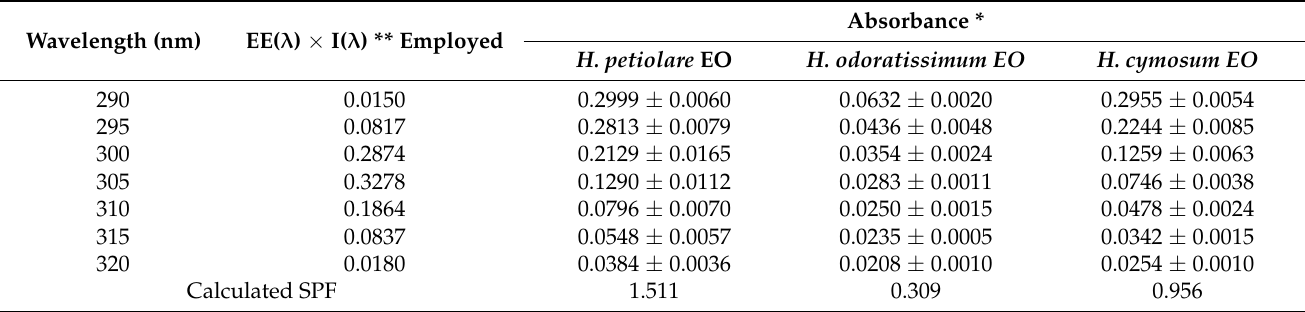
Table 8. Spectrophotometric absorbances of hydroalcoholic aliquots of the Helichrysum essential oils and their calculated